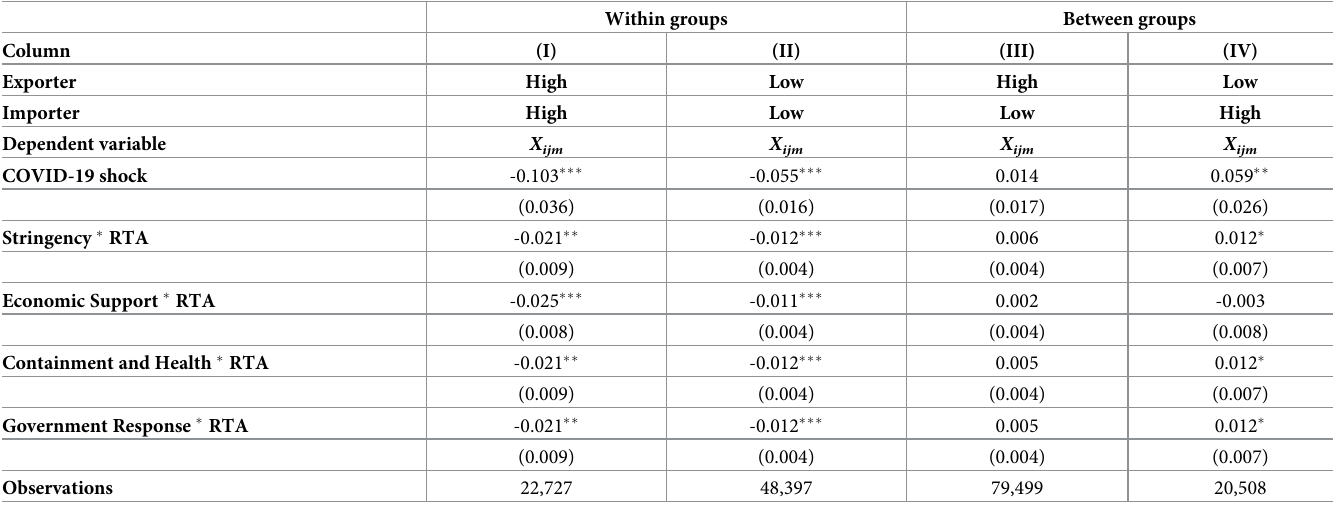
Within groups Between